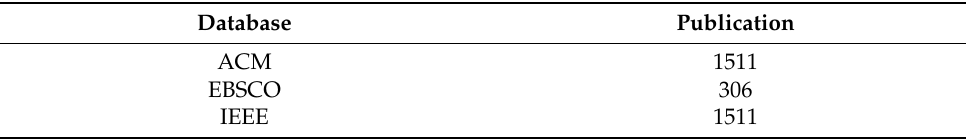
Table 1. Total publications found in the